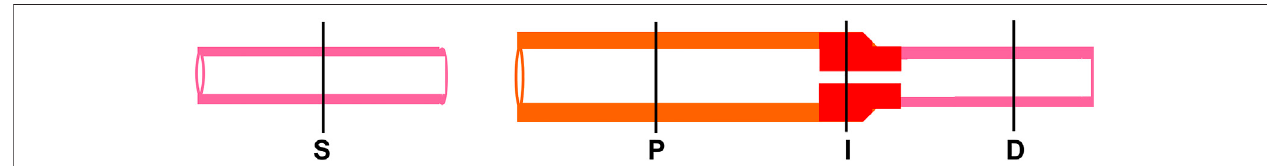
FIGURE 4 | Diagram of sham and CD-like colons showing different sites. S, sham colon. Site I, the in fl ammation site, is present with in fl ammation and mechanical stress. Site P is the mechanically distended colon site proximal to in fl ammation. It shows no sign of in fl ammation. Site D, the non-distended site distal to in fl ammation, presents neither mechanical stress nor in fl